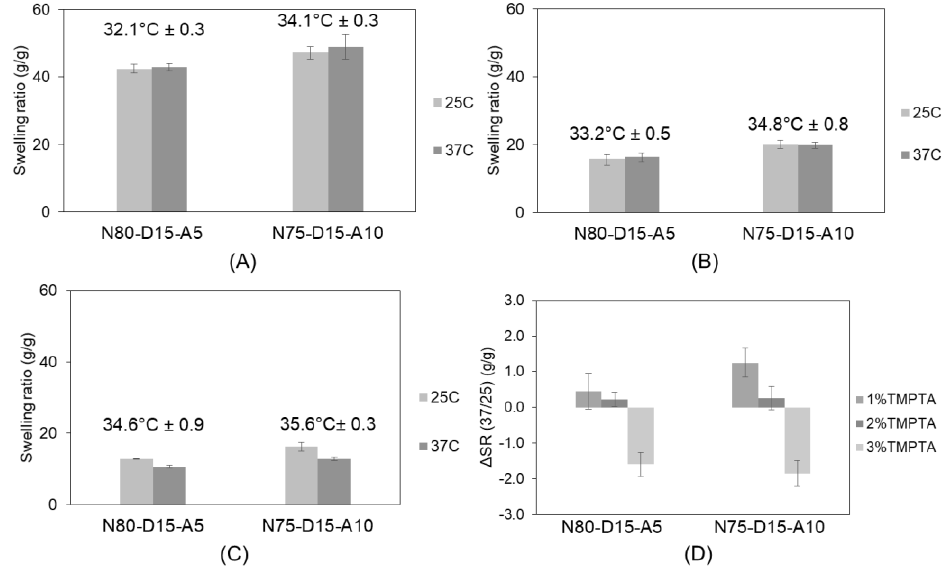
Figure 2. Swelling ratio at different temperatures and T trans of 1% TMPTA ( A ), 2% TMPTA ( B ), 3% TMPTA cross-linker ( C ), and ∆ SR (37/25) of 1%, 2%, and 3% TMPTA cross-linker ( D ). Negative value TMPTA cross-linker ( C ), and ΔSR (37/25) of 1%, 2%, and 3% TMPTA cross -linker ( D ). Negative indicates shrinkage of sample value indicates shrinkage of sample discs.